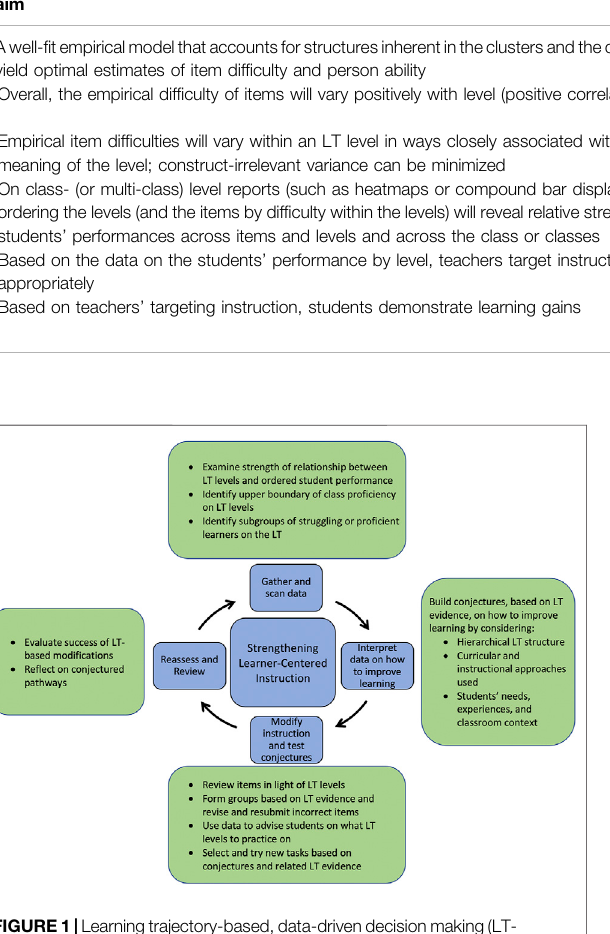
TABLE 1 | Chain of claims and evidence for MM6-8 assessments ’ validation argument.